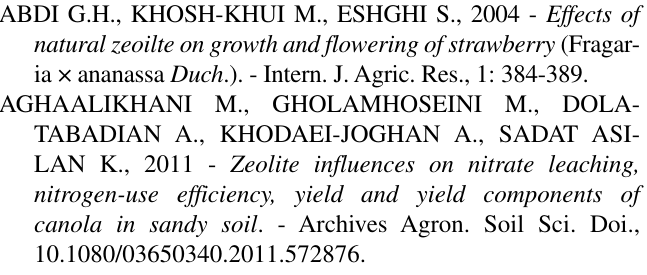
Fig. 7 - Effect of nitrogen and zeolite on clipping dry weight of roots (g) of Festuca arundinaceae Schreb‘Starlet